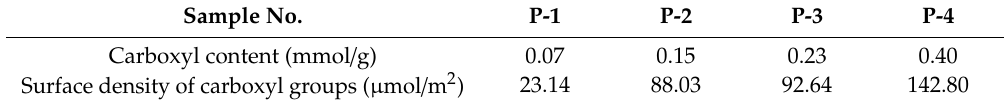
Table 2. Carboxyl concentration of P(MAA / St) microspheres prepared with di ff erent St:MAA ratios. Sample No.